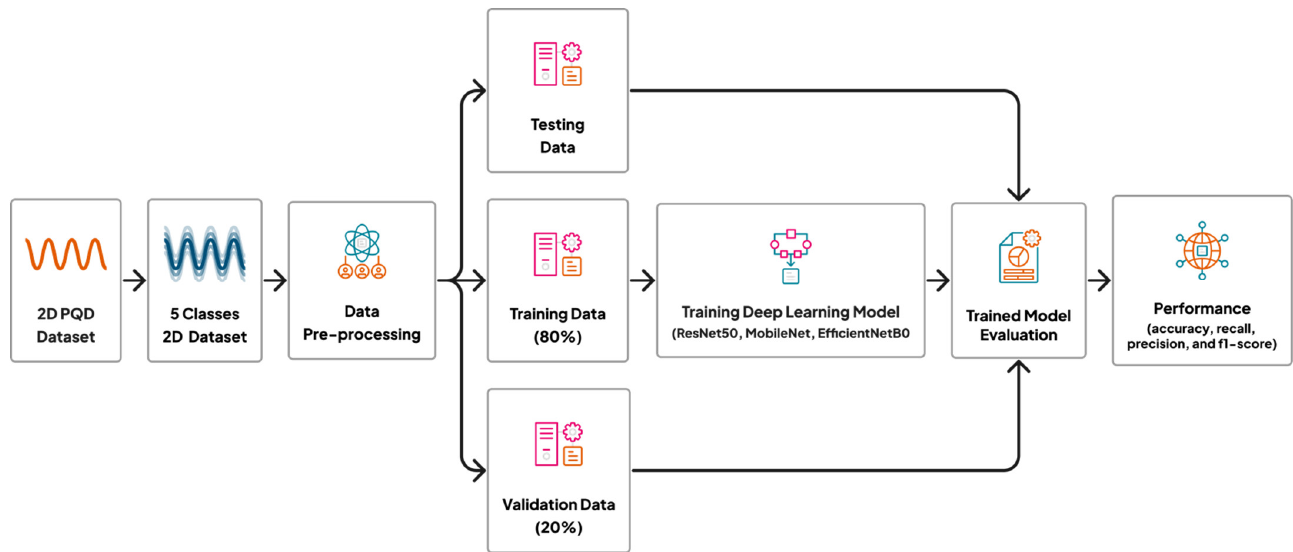
Figure 5. Stages of research method.